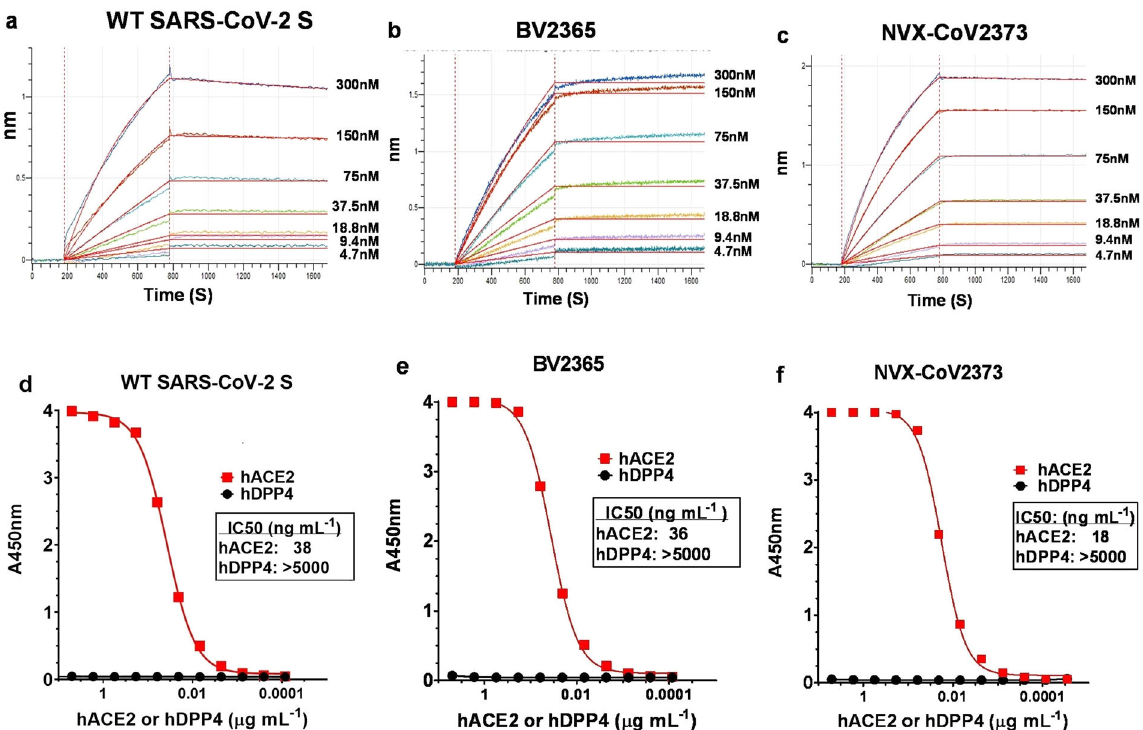
Fig. 2 Kinetics and speci fi city of SARS-CoV-2 S protein binding to hACE2 receptor determined by bio-layer interferometry (BLI) and ELISA. BLI sensorgram showing the binding of a wild-type (WT) SARS-CoV-2 S, b BV2365, and c NVX-CoV2373 spike proteins to histidine-tagged hACE2 receptor immobilized on a Ni-NTA biosensor tip. Data are shown as colored lines at different concentrations of spike protein. Red lines are the best fi t of the data. d WT-SARS-CoV-2 S, e BV2365, and f NVX-CoV2373 demonstrated binding to hACE2 receptor but failed to bind hDPP4 as determined by ELISA. Source data are provided as a Source Data fi le.